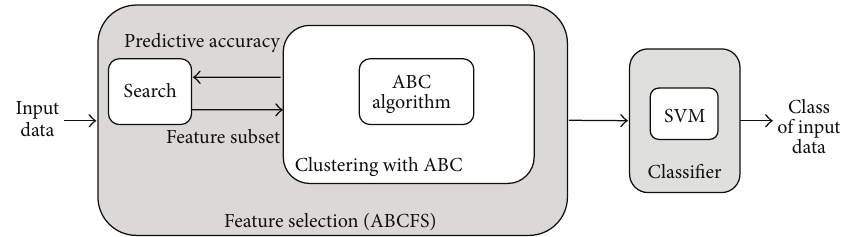
Figure 2: Block diagram of the proposed system.